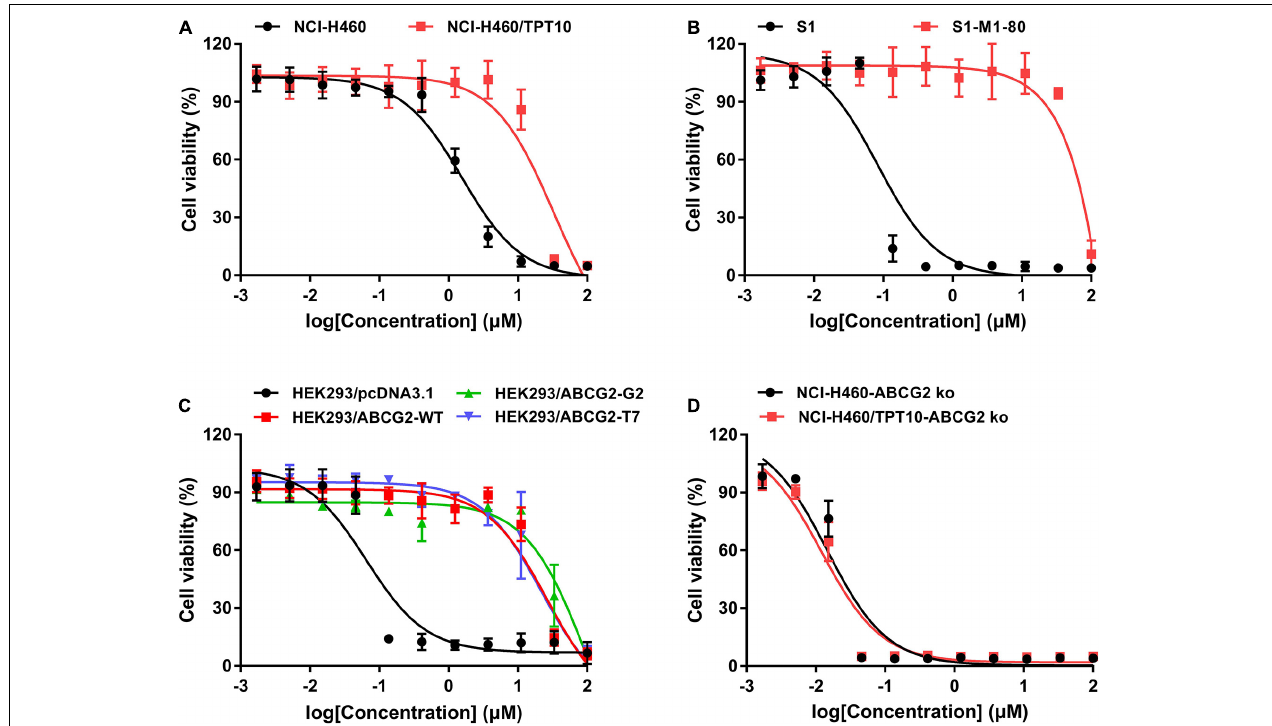
FIGURE 1 | The cytotoxicity of MLN7243 in parental and drug-resistant cell lines. Cell viability curves for (A) NCI-H460 and NCI-H460/TPT10 cells, (B) S1 and S1-M1-80 cells, (C) HEK293/pcDNA3.1 and HEK293/ABCG2-WT, -R482G, -R482T cells, and (D) NCI-H460-ABCG2 ko and NCI-H460/TPT10-ABCG2 ko cells. Data are expressed as mean ± SD from a representative of three independent